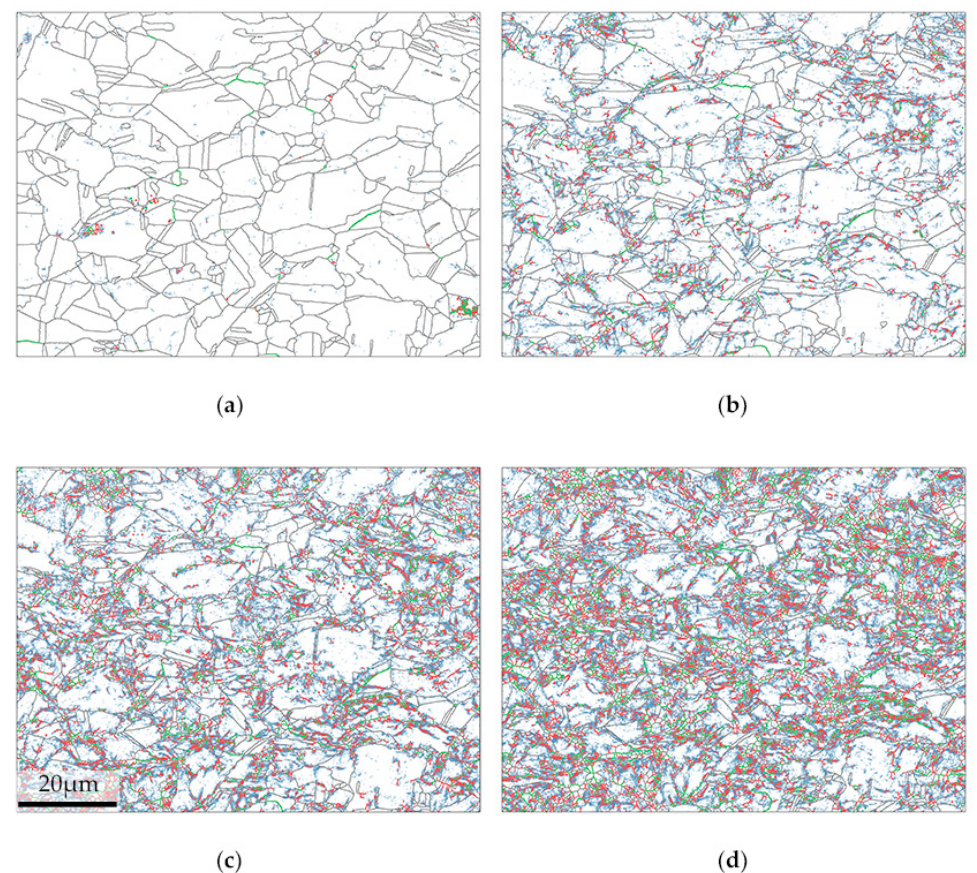
Figure 4. Grain boundary distribution and evolution during the in situ tensile test of CD, where blue, red and green lines represent grain boundary misorientation angles between 1–2°, 2–5° and 5–15°, respectively. Grain boundary misorientation angles larger than 15° are shown in black. EBSD was performed at strains of ( a ) 0%, ( b ) 12%, ( c ) 18% and ( d ) 24%.